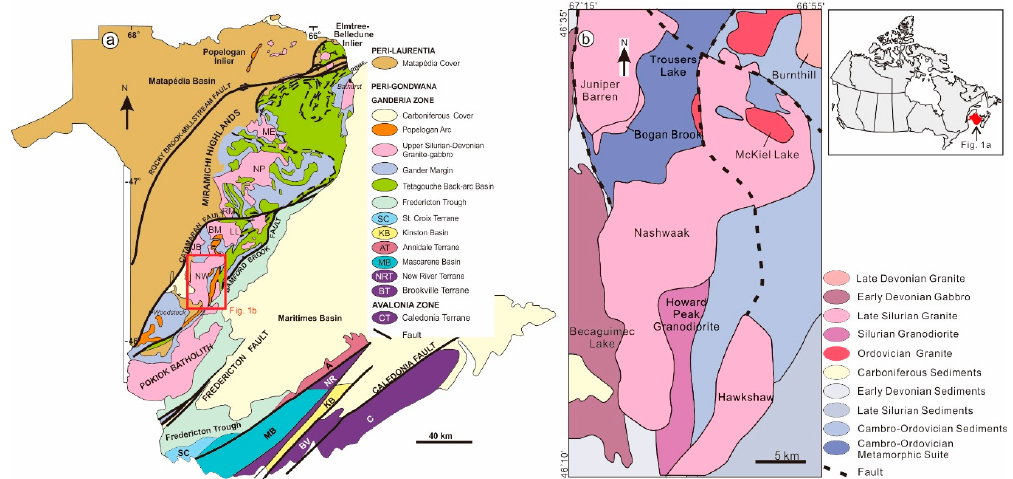
Figure 1. ( a ) Lithotectonic terranes of New Brunswick and ( b ) regional geological map, showing the